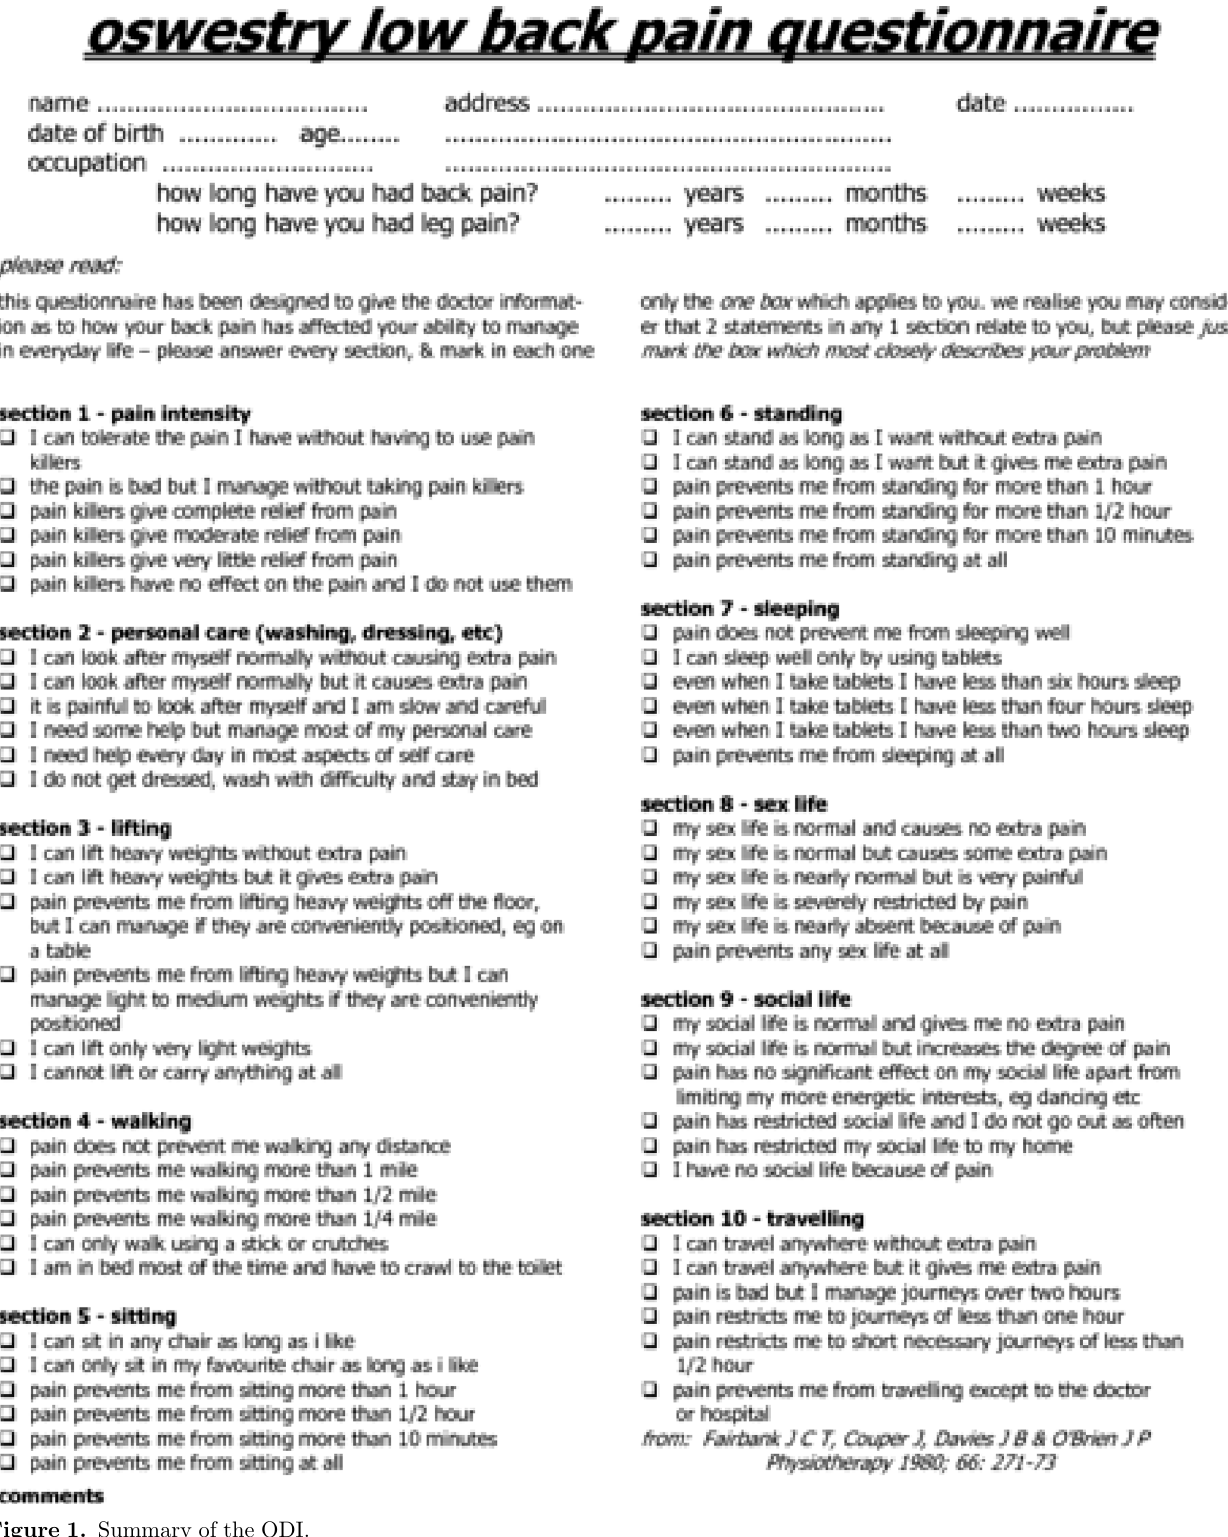
Figure 1. Summary of the